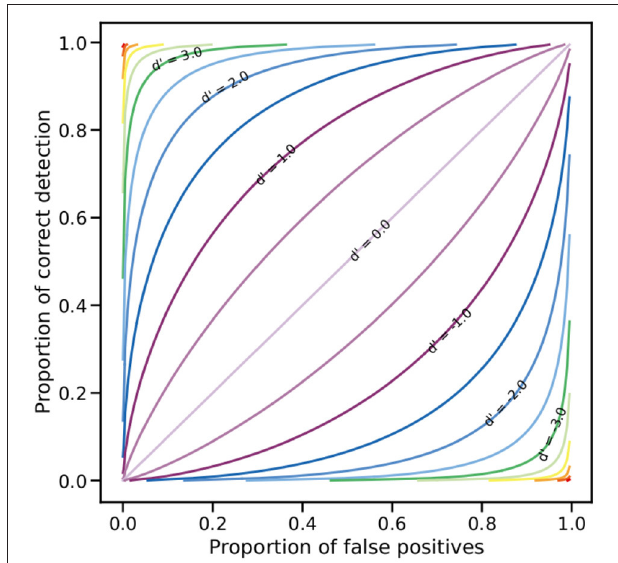
FIGURE 1 | Relative operating characteristic (ROC) on linear coordinates. Any point on a line represents the different combinations of hit rates and false positive rates leading to the same sensitivity index value ( d ′ ). The diagonal ( d ′ 0) represents the chance line where the hit and false positives rates are = equal; as sensitivity increases, i.e., d ′ > 0, the slope of the lines also increase. Negative d ′ values are obtained when sensitivity decreases from chance level as a result of a higher proportion of false positive relative to the hit